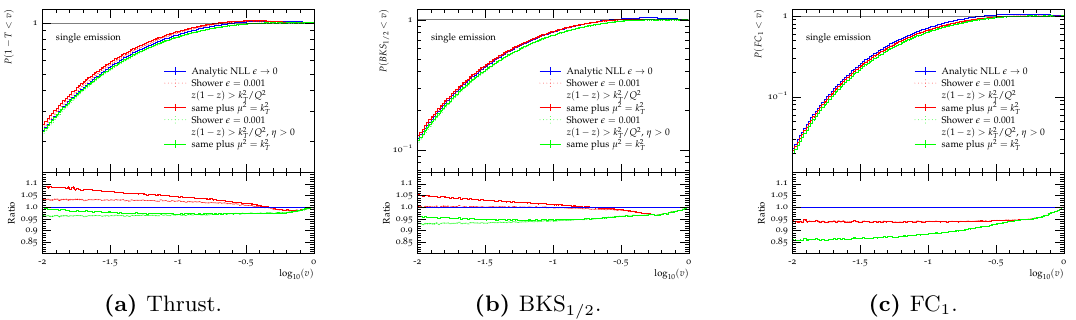
Figure 2 . E(cid:11)ects arising from momentum-conservation in the anti-collinear direction and from phase-space sectorization (removal of soft double counting in typical parton-shower implementa- tions). Both are e(cid:11)ects at the single-emission level, impacting terms in R ( v ), cf. table